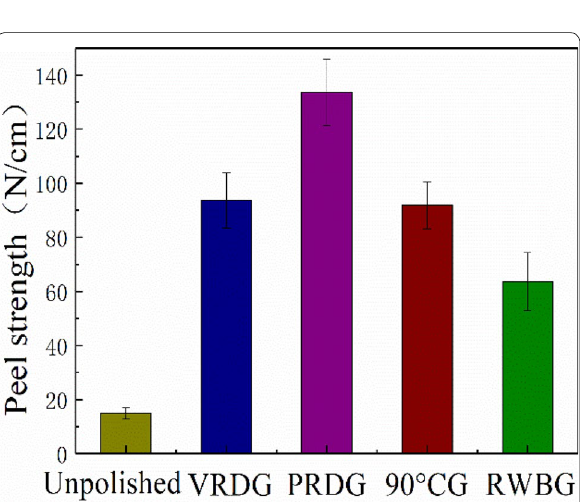
Fig. 7 Peeling properties of Cu/Al clad plates with different mechanical